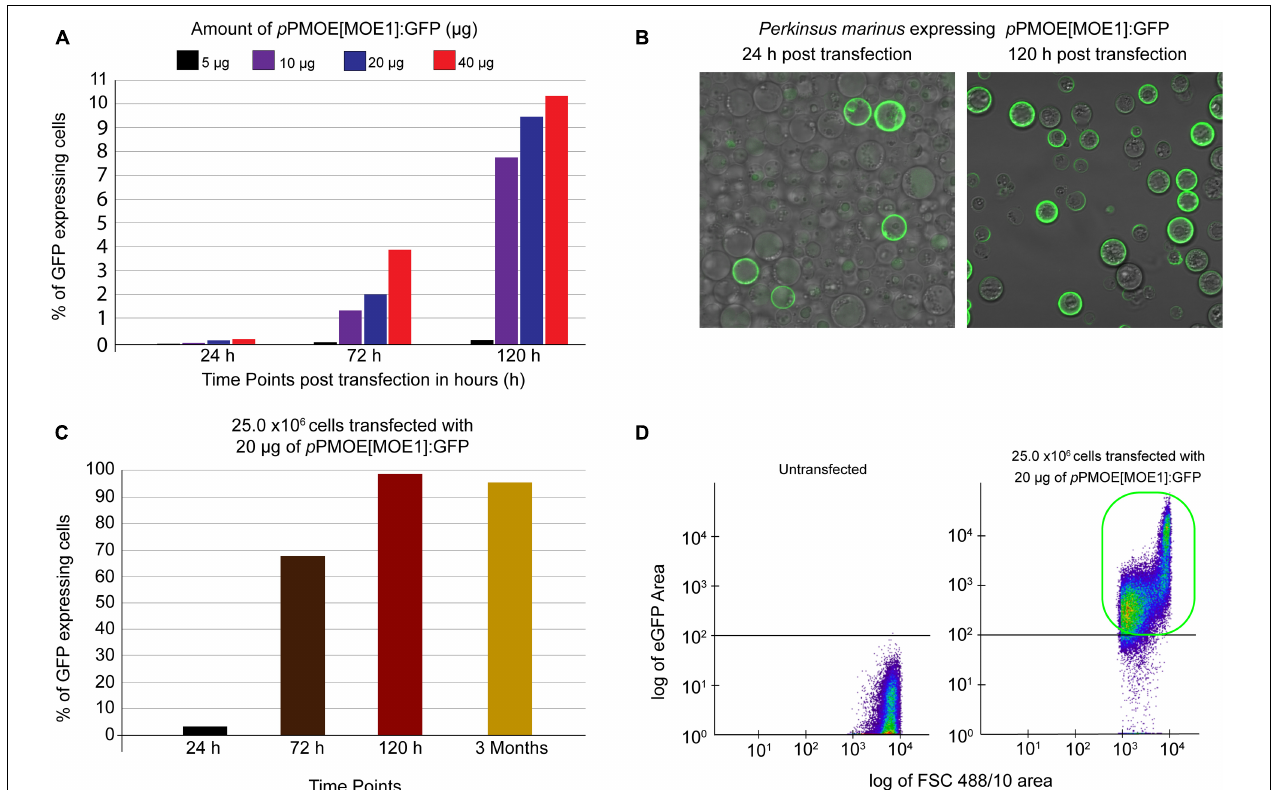
FIGURE 1 | Plasmid amount and cell number optimization studies. (A) Fifty million parasites transfected with 5 µ g (black bar), 10 µ g (purple), 20 µ g (blue), and 40 µ g (orange) of p PmMOE[MOE1]:GFP, respectively. Bar graphs showing that the %GFP-positive cells (y-axis) were detected by flow cytometry at 24, 72, and 120 h post-transfection time points (x-axis). (B) Twenty-five million parasites transfected with 20 µ g of p PmMOE[MOE1]:GFP 24 and 120 h post-transfections. (C) Twenty-five million parasites were transfected with 20 µ g of p PmMOE[MOE1]:GFP, respectively. Bar graphs showing the %GFP-positive cells (y-axis) detected by flow cytometry at 24 (black bar), 72 (brown bar), 120 h (dark red bar), and 3 month (yellow bar) post-transfection time points (x-axis). (D) The scattered plot from FCM showing no GFP expression in untransfected controls and 98% GFP-positive cells in 25.0 × 10 6 cells transfected with 20 µ g of p PmMOE[MOE1]:GFP indicated in the green